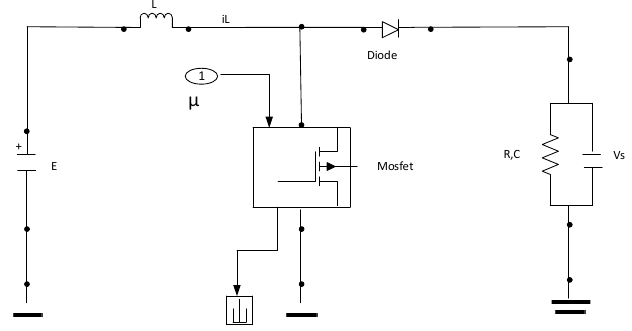
Figure 5. Schematic of ideal Boost converter.